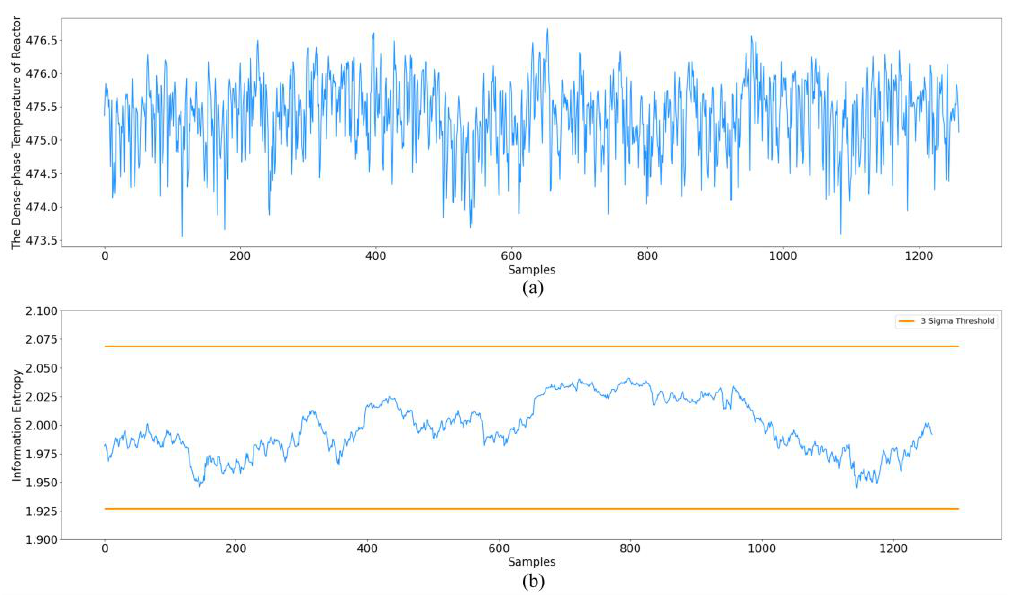
Figure 5. Initial manually labeled normal samples and their information entropy: ( a ) original labeled normal samples; ( b ) information entropy of these normal samples.